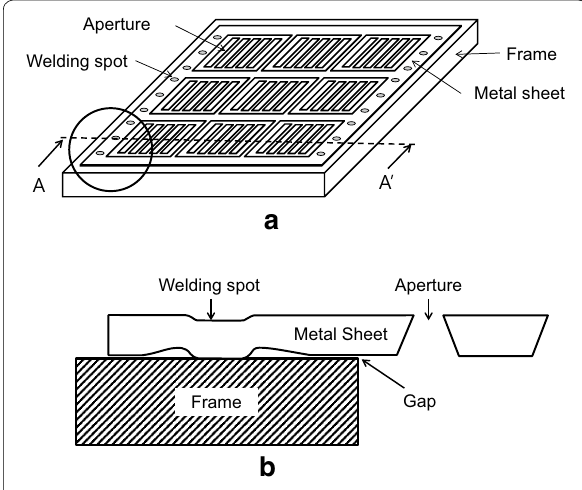
Fig. 1 Schematic illustration of a typical FMM fabricated by laser welding of a thin metal sheet onto stainless steel frame: a whole diagram and b cross‑sectional view of the circled part on the line A–A ′